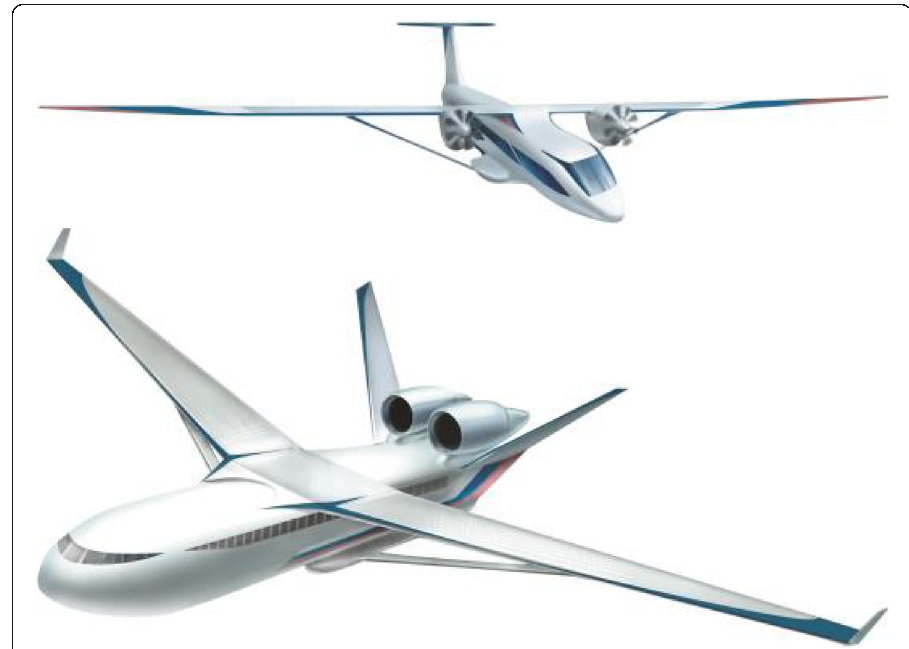
Fig. 2 Layout of aircraft with wing